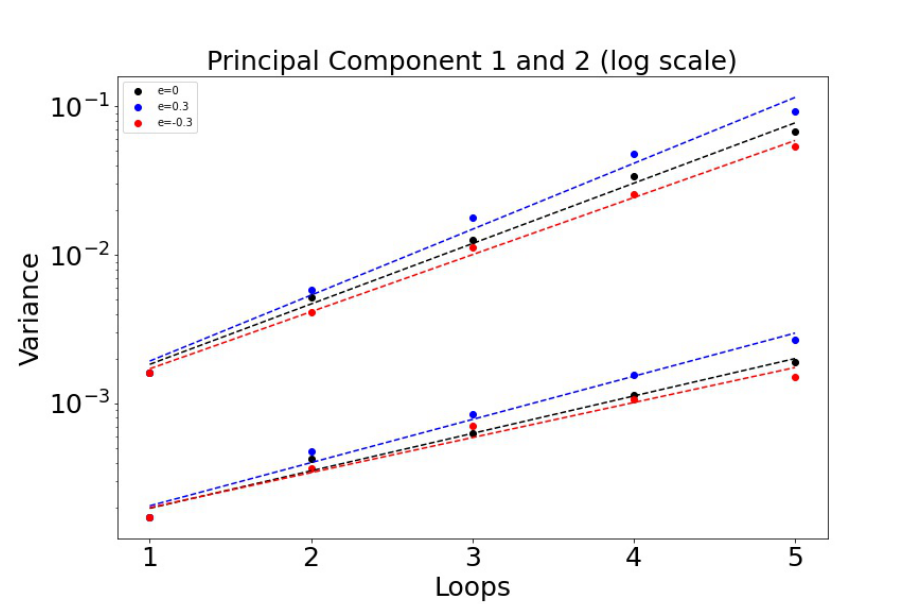
Figure 7. Variance σ e of the principal components as a function of the cycle number n plotted on log–linear axes, so σ e ∼ a exp ( α e n ) . Note that antagonistic interactions grow the slowest, while synergistic interactions grow the fastest. α 0 : 0.936 (PCA 1) and 0.580 (PCA 2). α 0.3 : 1.02 and 0.670. α − 0.3 : 0.885 and 0.543.